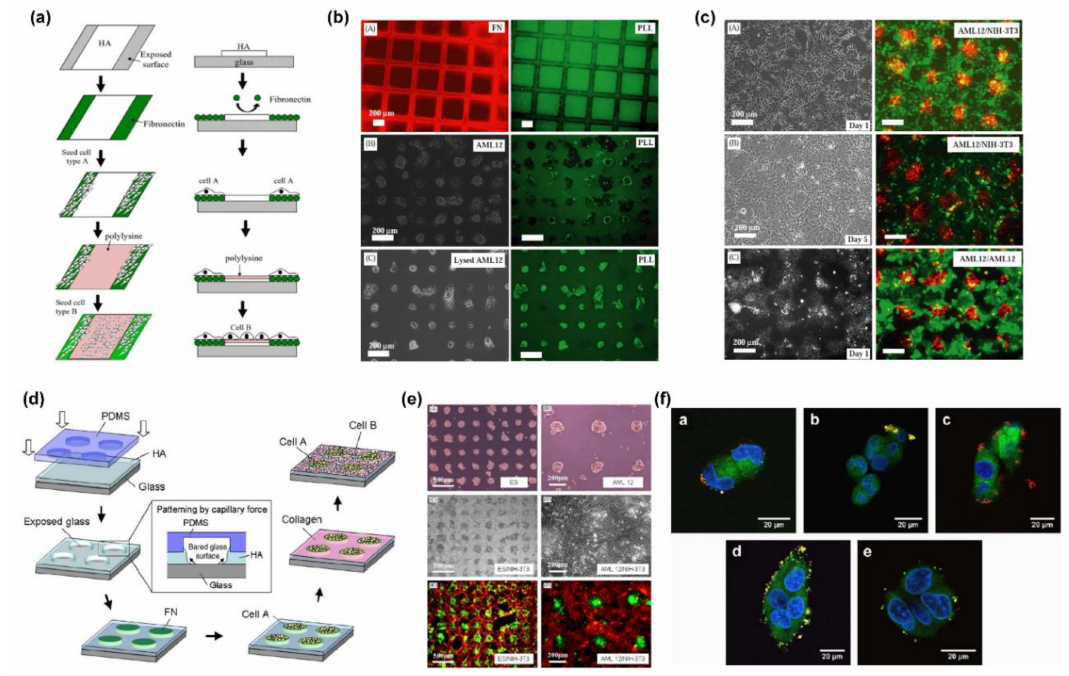
Figure 6. ( a ) Schematic diagram showing the layering approach to pattern cell co-cultures; ( b ) patterned hyaluronic acid surfaces attached with poly- L -lysine and immobilized cells; ( c ) patterned co-cultures of hepatocytes with fibroblasts; ( d ) schematic diagram of the fabrication of the co-culture system using LbL assembly technique; ( e ) patterned cell culture and co-culture on hyaluronic acid/collagen surface; ( f ) confocal laser scanning microscopy images of hepatocytes after co-culture on different chitosan/alginate LbL assembly films with nanoparticles. Reprinted from [99–101] with permissions from